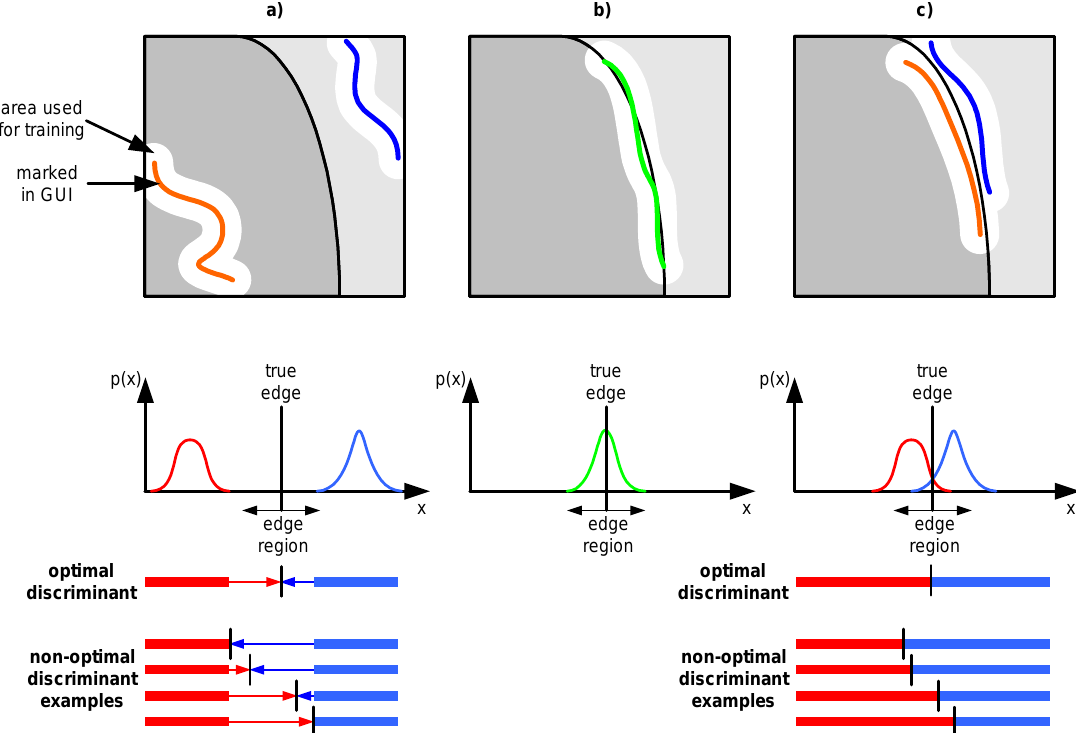
Figure 3. Examples of manual labeling, achieved distribution and possible regions discriminations (( a ) inner regions labeling, ( b ) regions edge labeling, ( c ) near-to-edge labeling). Manual selection, depicted as a color curve, allows the local selection of surrounding pixels around such a curve which are depicted as fat white curves corresponding to particular selection. White